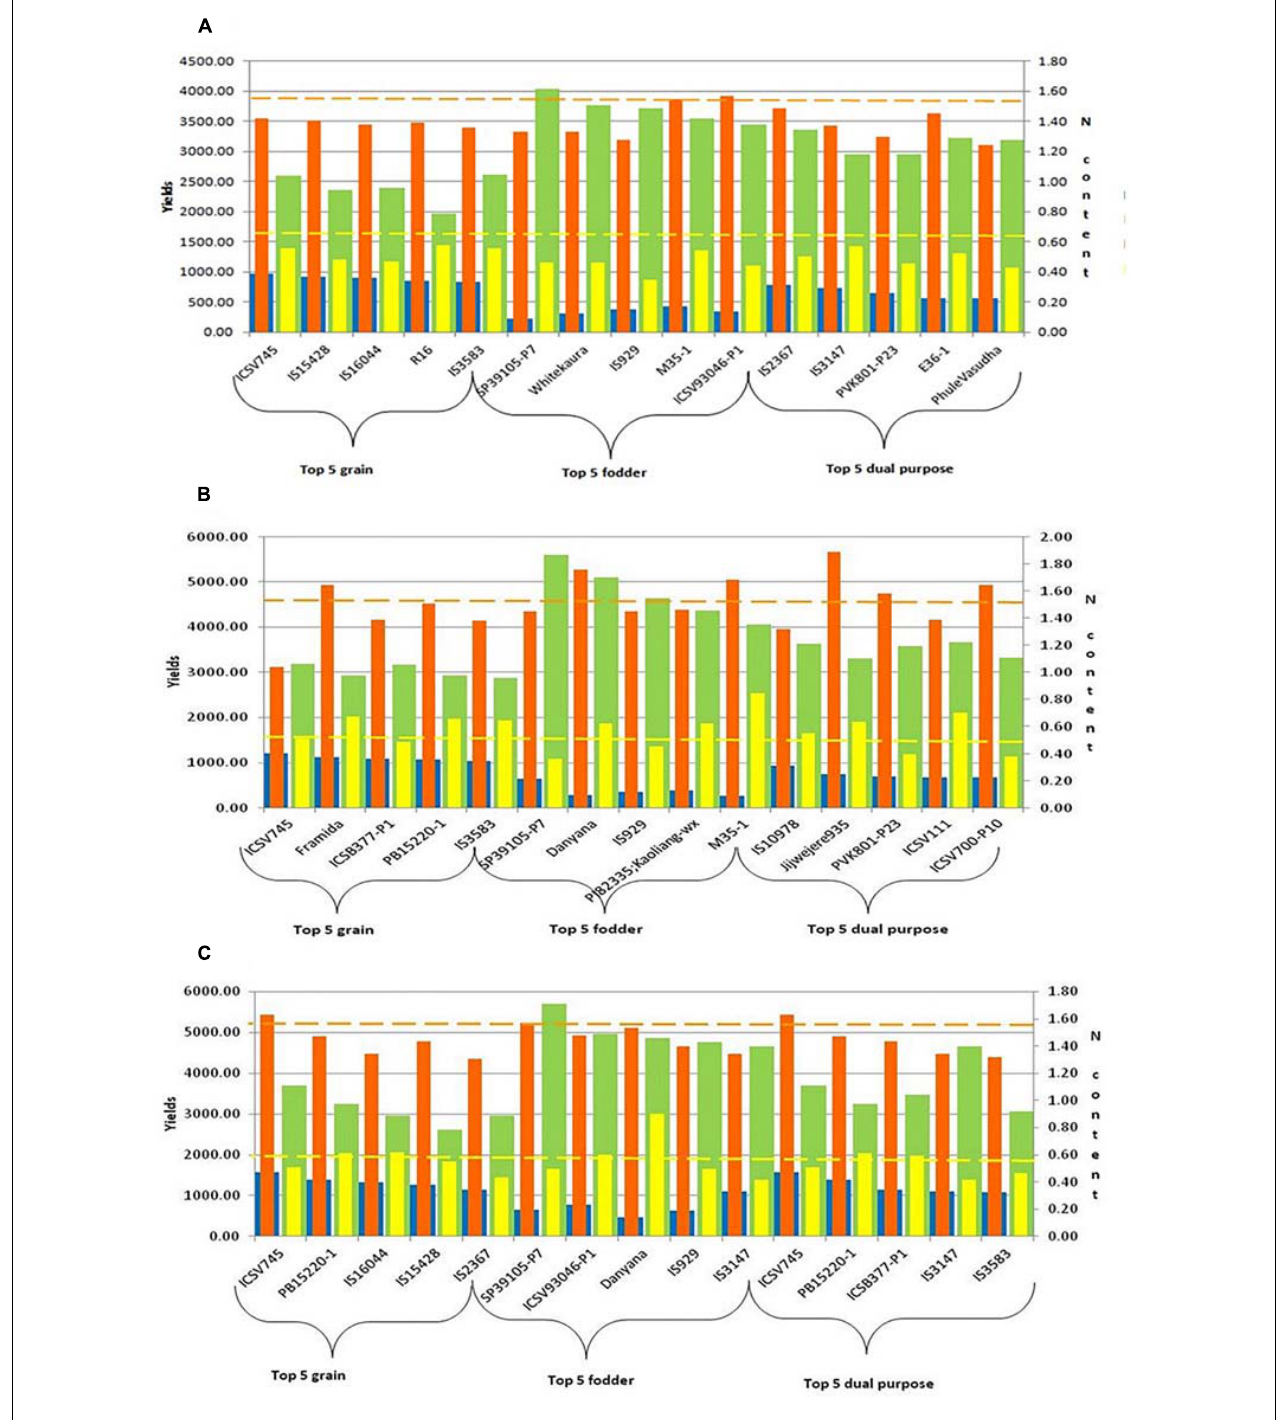
FIGURE 4 | Top five grain, fodder and dual purpose sorghum genotypes under different N ( A: N0, B: N50, and C: N100) regimes [Note: (cid:4) GY (g): Grain yield (g); (cid:4) DSY (g): Dry stak yield (g); (cid:4) GN%: N content in grain; (cid:4) SN%: N content in stak].